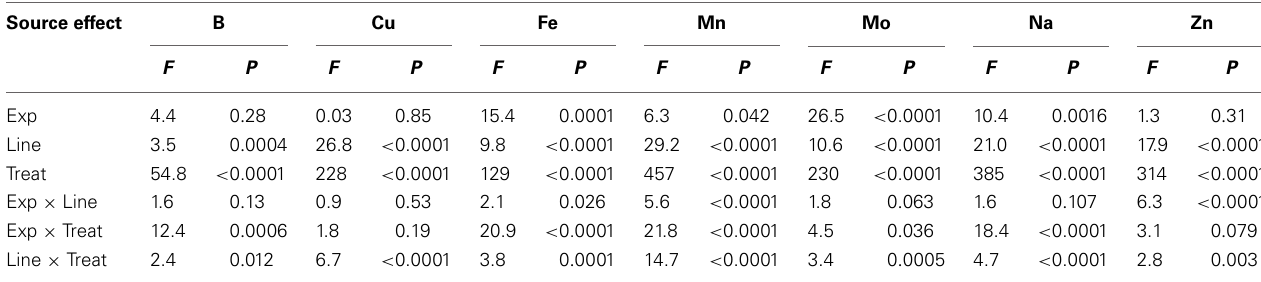
Table 2 | Analysis of variance ( F and P values) of the effects of water treatment (Treat) on cottonseed micronutrients in fuzzless and fuzzy seed cotton isogenic mutant lines (Line) in greenhouse experiments (Exp).